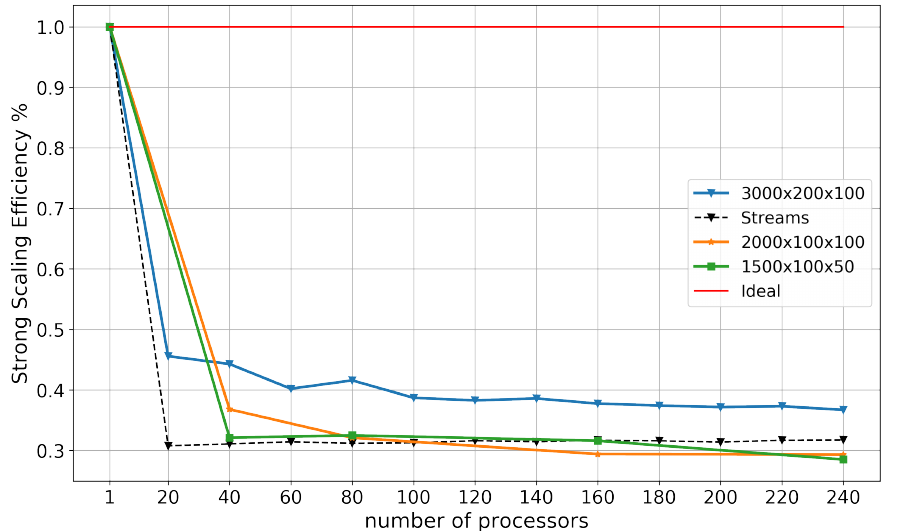
Figure 7. Speedup scaling for stratified seamount experiments of different resolutions compared to the Portable, Extensible Toolkit for Scientific Computation (PETSc) streams test results for the test system [16]. The theoretical ideal is shown for reference.